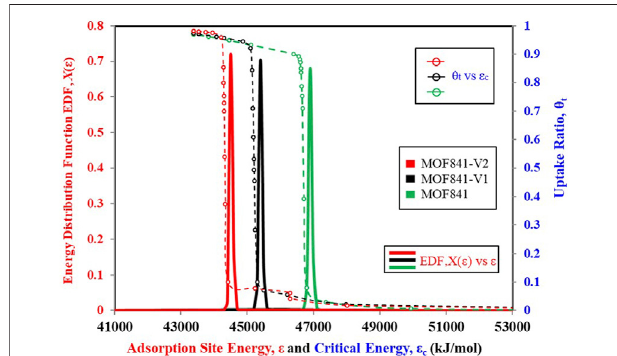
FIGURE5| Variations inthe fractional share oftheadsorption sitegroup in MOF 801 and variants.